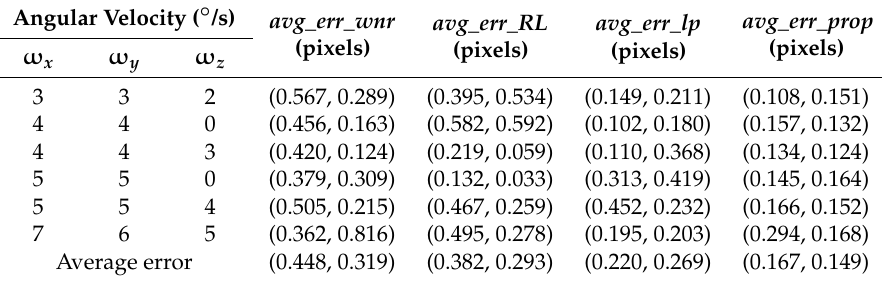
Table 2. The average centroid position error of different reconstruction